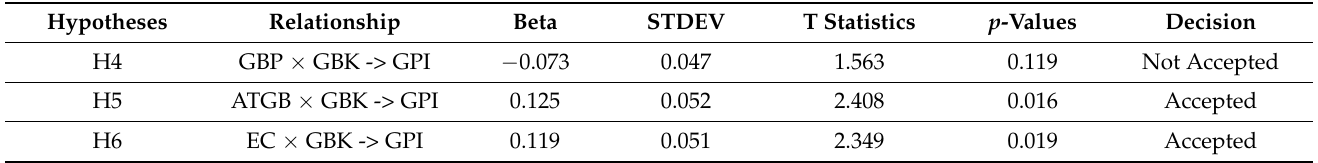
Table 10. Moderation